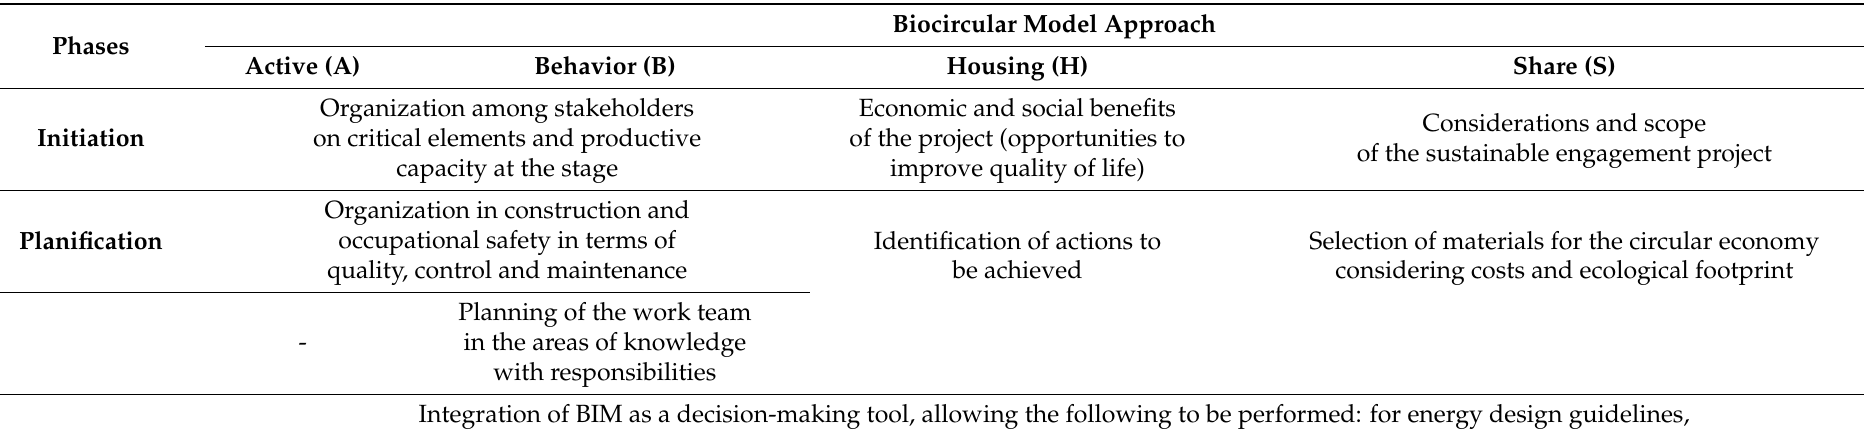
Table 2. Biocircular Model Approach to each Sustainable Construction